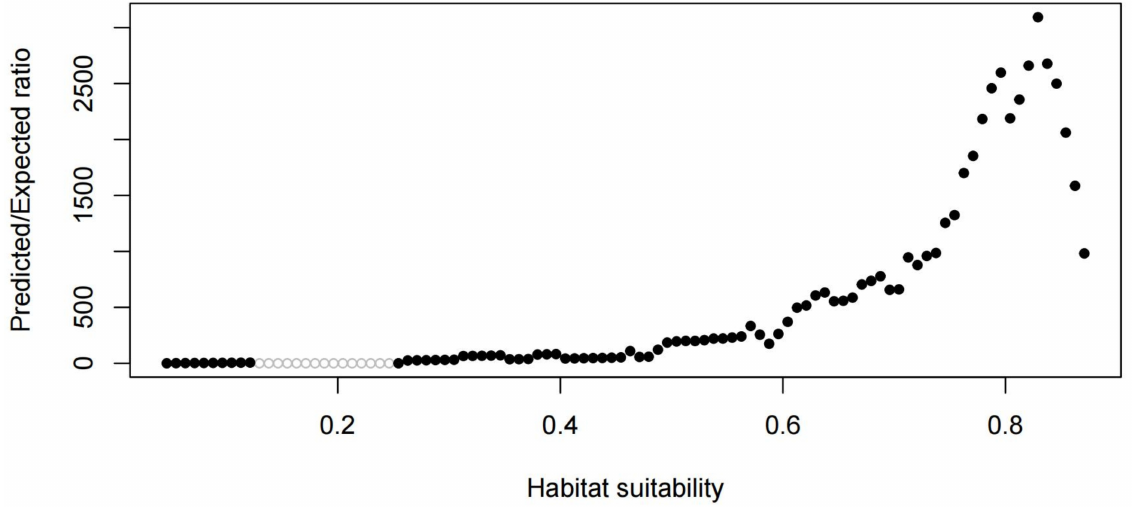
Figure 4. CBI = 0.975. CBI is used as a reliable performance